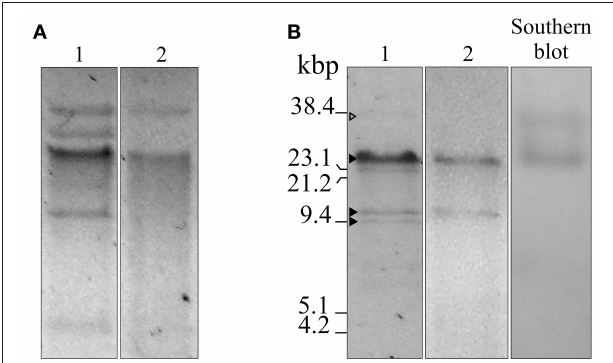
FIGURE 1 | Agarose gel electrophoresis, S1 nuclease, and Southern blot analyses of plasmids isolated from A. baumannii Ab242 and A. nosocomialis M2 transformed with Ab242 plasmids. (A) Gel electrophoresis (0.7% agarose)/ethidium bromide staining of total plasmids extracted from